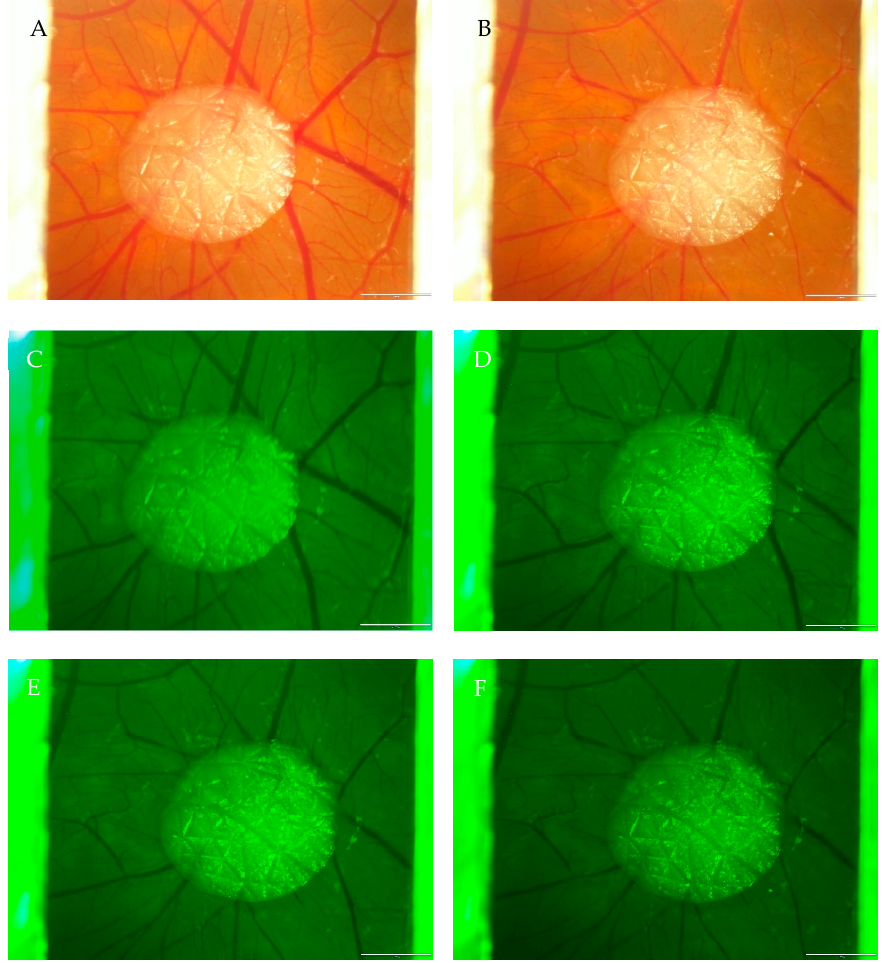
Figure 2. Rose Bengal induced vessel changes in CAM with split skin grafts ( A ) before and ( B ) af- ter 10 min of illumination. ( C ) Illumination process t—0 min, ( D ) illumination process t—4 min, ( E ) illumination process t—8 min, ( F ) illumination process t—10